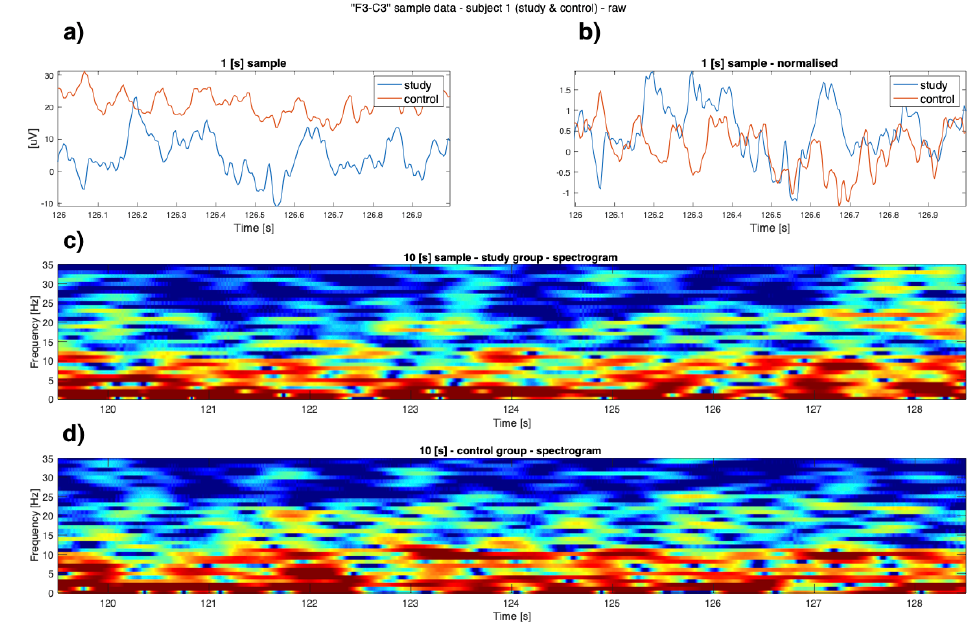
Figure 4. Example raw data from channel ’F3-C3’ : ( a ) time-series of both study group and control group (1 [s]); ( b ) normalised time series of study group and control group (1 [s]); ( c ) 10 [s] sample of FASD (top spectrogram); ( d ) 10 [s] of healthy control (bottom spectrogram)—sample